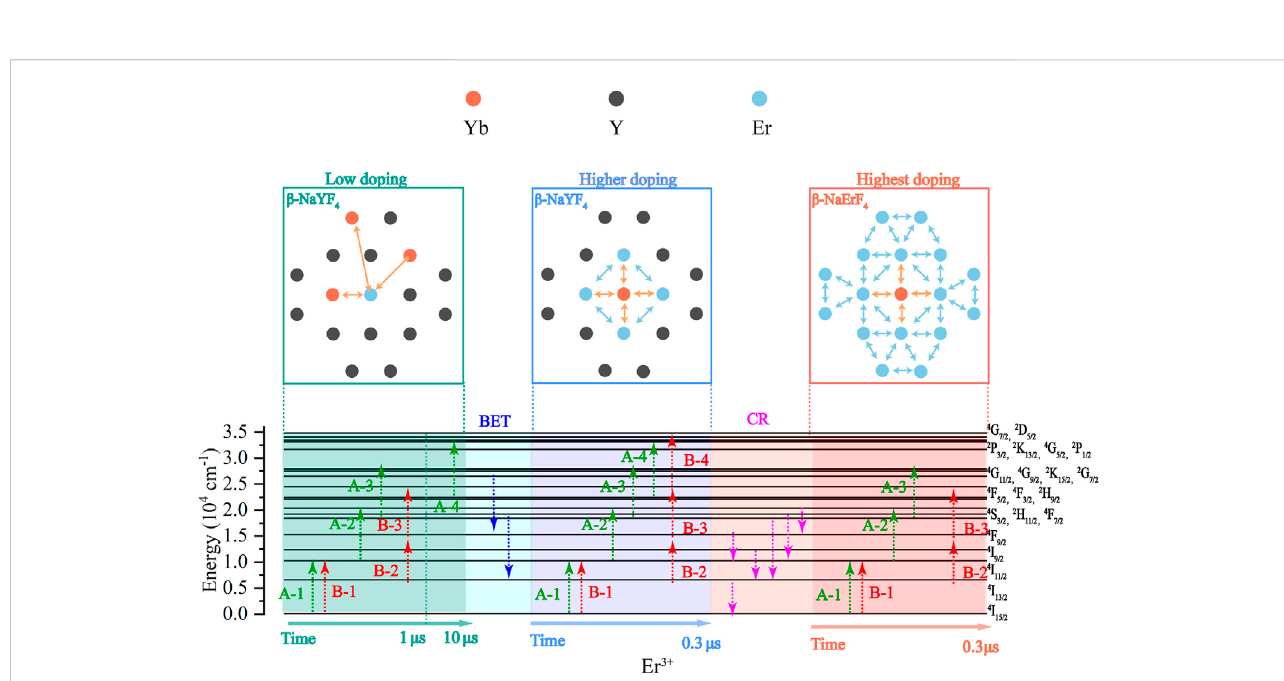
FIGURE 6 Schematic diagram of the in fl uence of Er 3+ doping concentration on the UCL emission of NaYF 4 :Yb 3+ /Er 3+ MCs under the excitation of 976 nm laser.